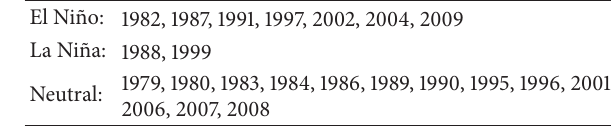
Figure 6: JJA CFS reanalysis climatology 1979–2009 precipitable water shaded (units: mm). Table 1: Years used in composite analysis for moderate to strong El Ni˜no, moderate to strong La Ni˜na, and neutral years. Composites based on JJA EIS values normalized by JJA standard